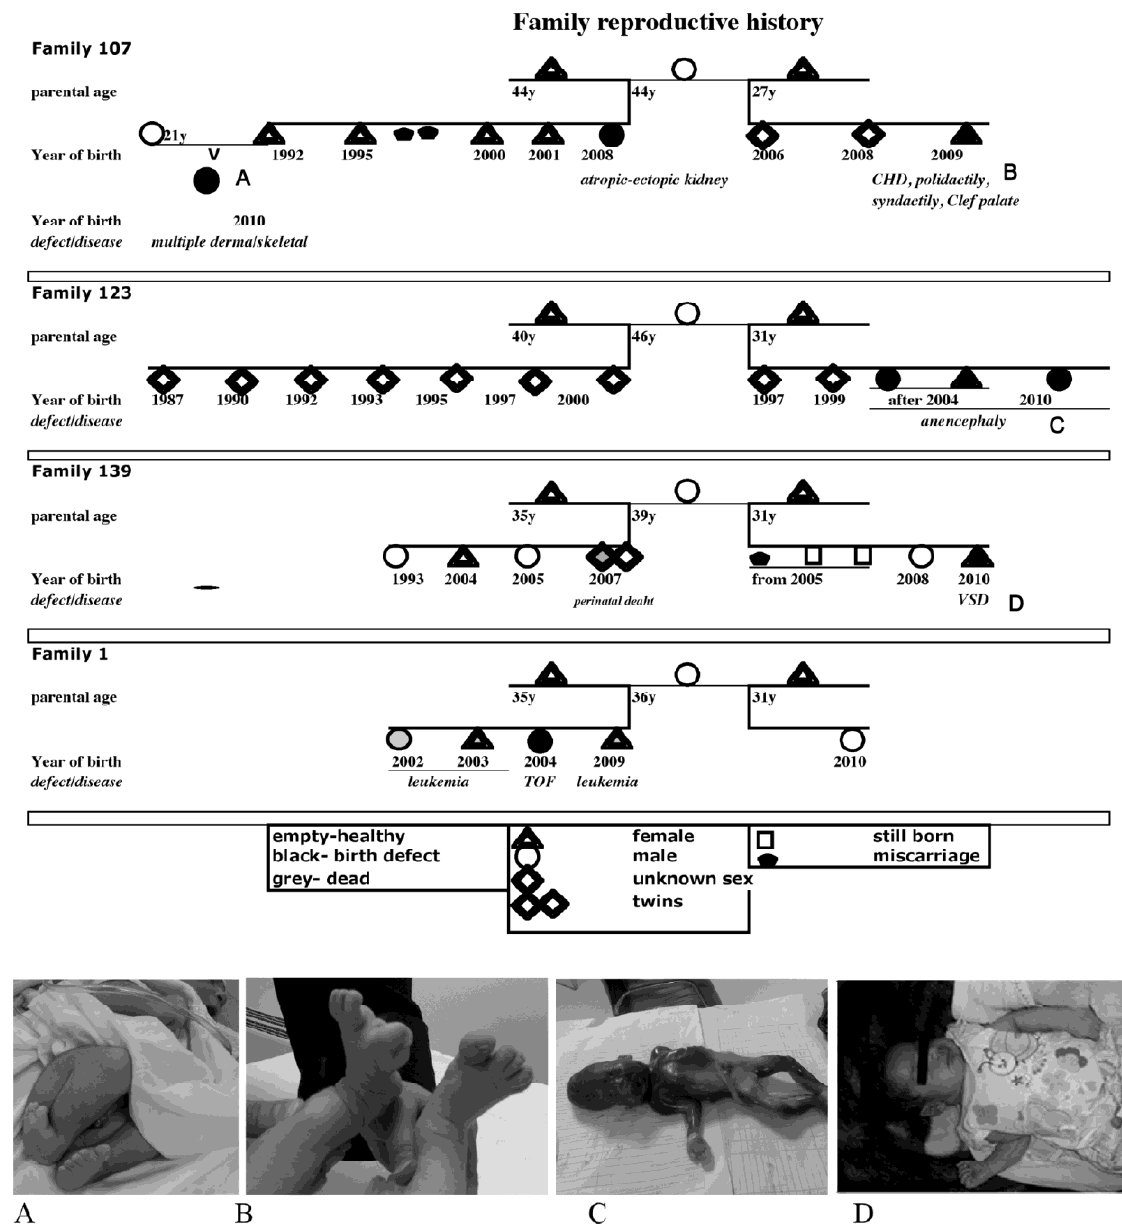
Figure 1. Top panel-family reproductive history is graphically represented. Bottom panel-Photographic record of birth defects: (A) Male child diagnosed with very short webbed neck, rocker bottom feet, malformed thighs, and legs flexed at hips, knees and ankles, retracted penile skin-born full term, August 7, 2010—Family 107—daughter progeny. (B) Female child diagnosed with cleft palate, poly and sindactily of both feet and right hand and congenital heart defect-born at 42 weeks, October 1, 2009—Family 107. (C) Induced abortion (at 22 weeks) of a male fetus with anencephaly, May 31, 2010. (D) Female child, with ventricular septal defect (VDS), born at full term, April 28, 2010—Family 139. Patient consent for publication of the data was obtained from all